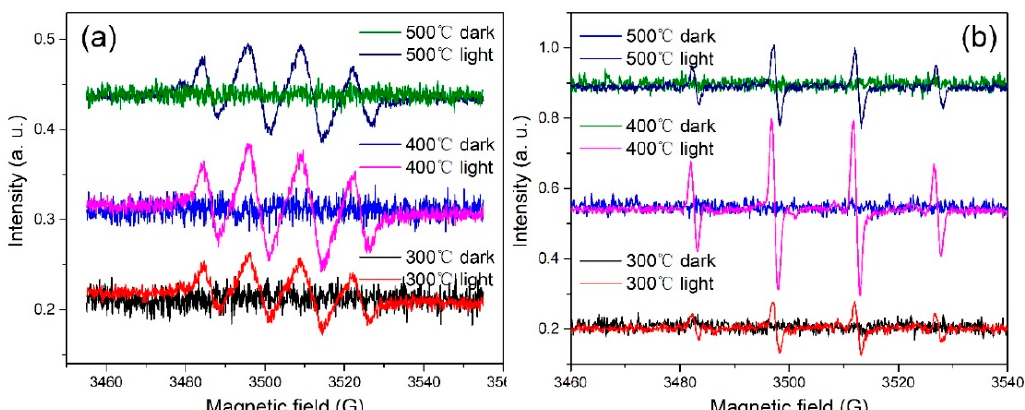
Figure 11. EPR spectra of the hierarchical ZnO microsphere catalysts annealed at 300, 400, and 500 °C in the dark and under light irradiation: ( a ) DMPO-O 2 − and ( b ) DMPO-OH.